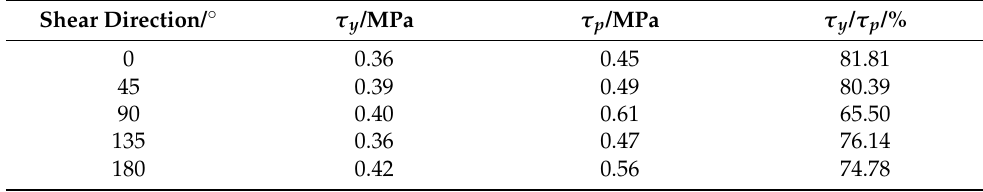
Figure 17. Schematic diagram of the selected rock joints [81]. Table 6. Yield stress under different shear directions.